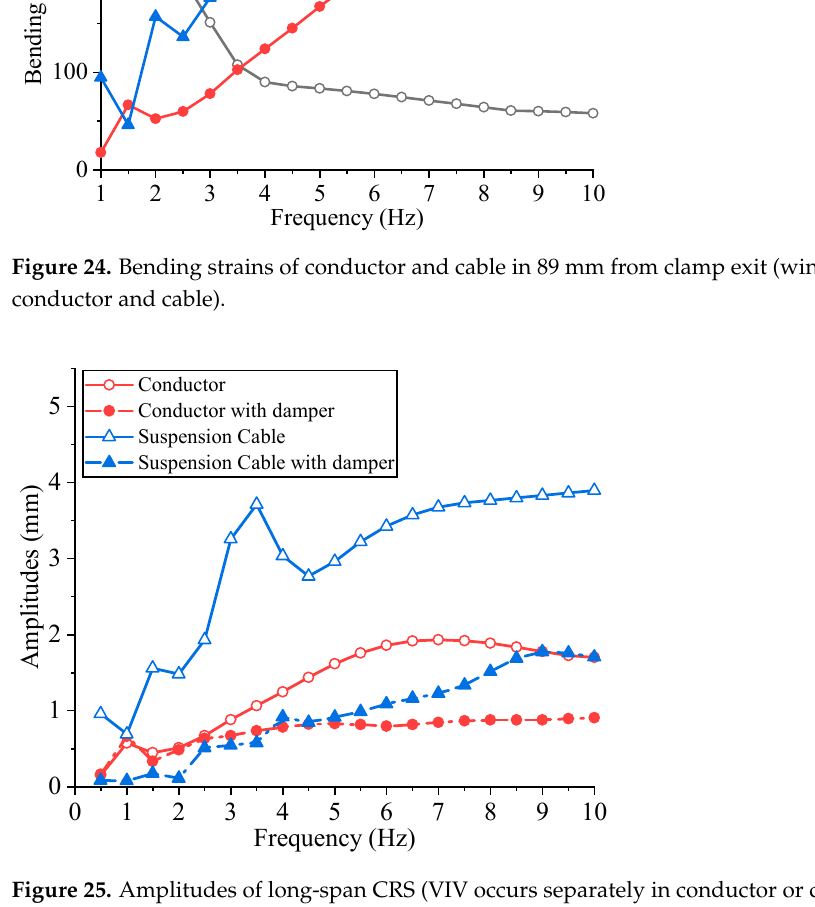
Figure 25. Amplitudes of long-span CRS (VIV occurs separately in conductor or cable).